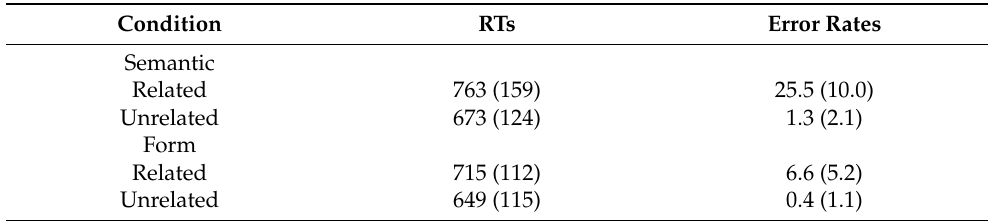
Table 3. Mean reaction times (ms) and error rates (%) in the four experimental conditions (standard deviations in